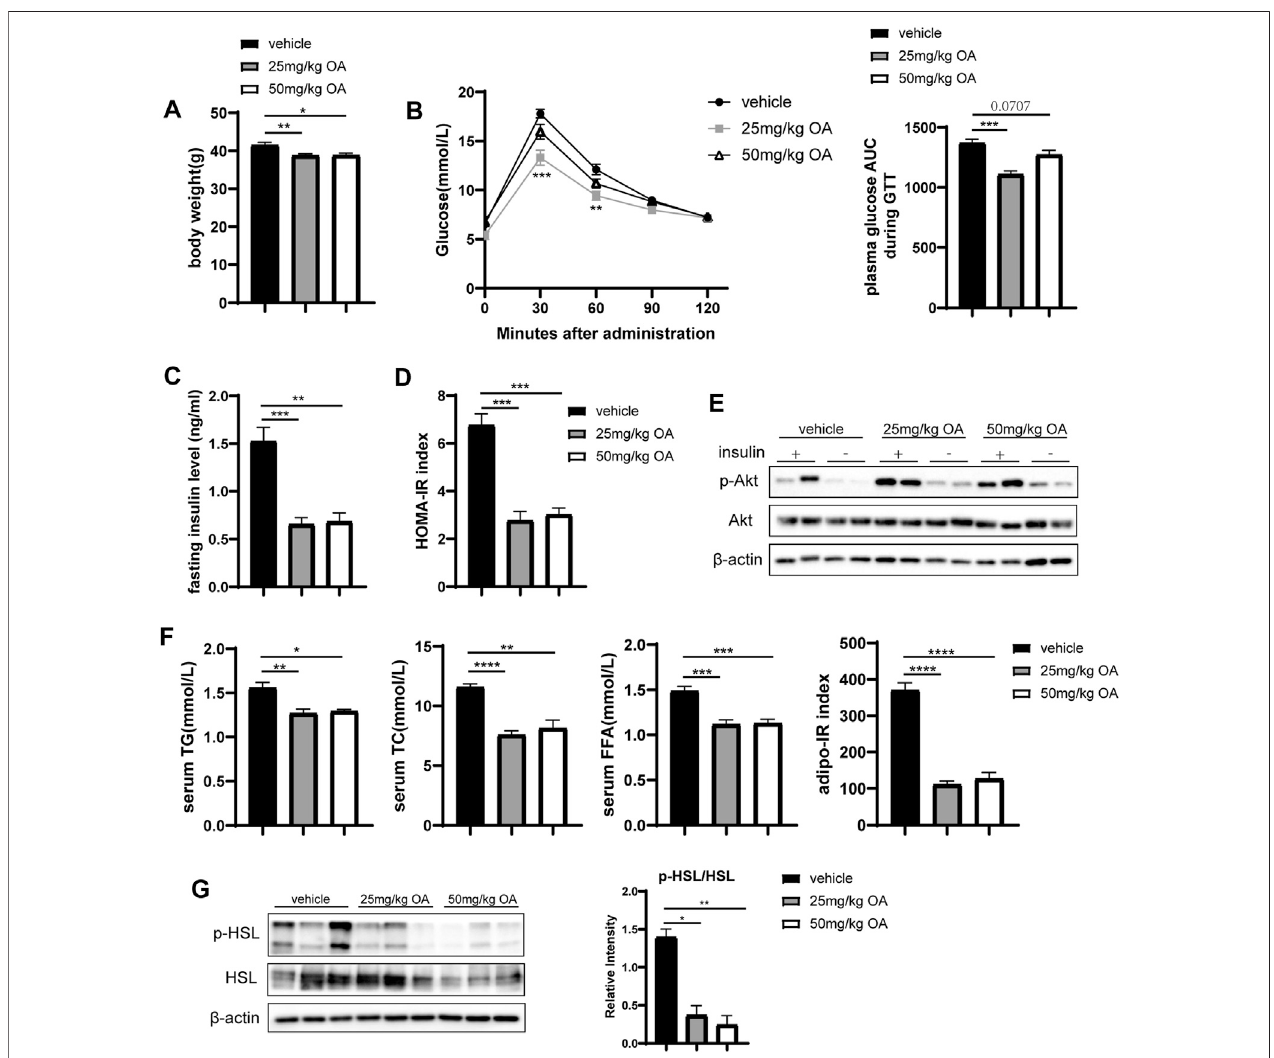
FIGURE1| OAimprovesglucoseandlipidmetabolismandalleviatesdiet-inducedIR. (A) Bodyweightofmiceinvehicle,25 mg/kgOA,50 mg/kgOAgroupatthe end oftheexperiment ( n (cid:1) 7). (B) Glucose tolerance test (GTT) inmice after 4 weeks ofOAtreatment ( n (cid:1) 7). (C) Fastingplasmainsulinlevels ( n (cid:1) 7). (D) HOMA-IR index ( n (cid:1) 7). (E) Western blots of phospho-Ser473 Akt (p-Akt), and Akt in eWAT of mice. (F) Plasma concentrations of triglyceride, total cholesterol, FFA at baseline (fasted), andAdipo-IRindex( n (cid:1) 5 – 7). (G) Westernblotsofphospho-Ser660HSL(p-HSL),andHSLintheeWATofmice.* p < 0.05,** p < 0.01,*** p < 0.001,**** p < 0.0001.